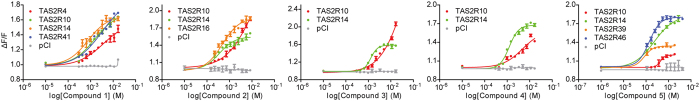
The dose-response curves of all 15 bitterant-TAS2R interactions listed in Table 3.y-axis represents ΔF/F ± SEM (N = 2). “pCI” denotes the response of mock-transfected cells to each compound.